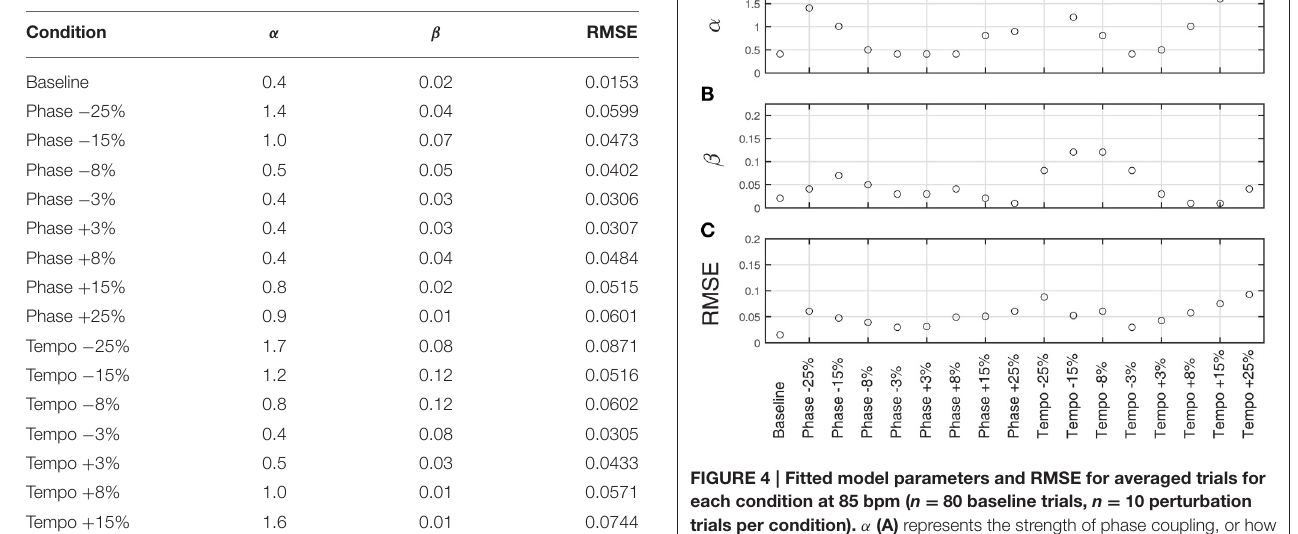
TABLE 2 | Phase ( α ) and Period ( β ) coupling parameter values and Root Mean Squared Error (RMSE) for model fits of Ronan’s experimental data at 85 bpm.